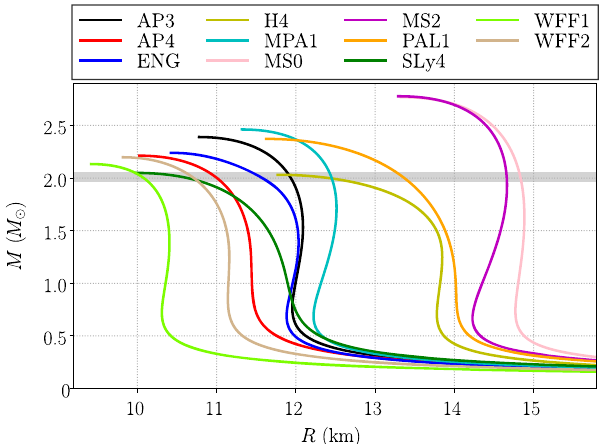
FIG. 2. The mass-radius relation of NSs (in GR) for the 11 EOSs that are adopted in the study. The mass constraint (with 1 σ uncertainty) from PSR J 0348 þ 0432 [35] is depicted in grey. The color coding for different EOSs is kept consistent for all figures in